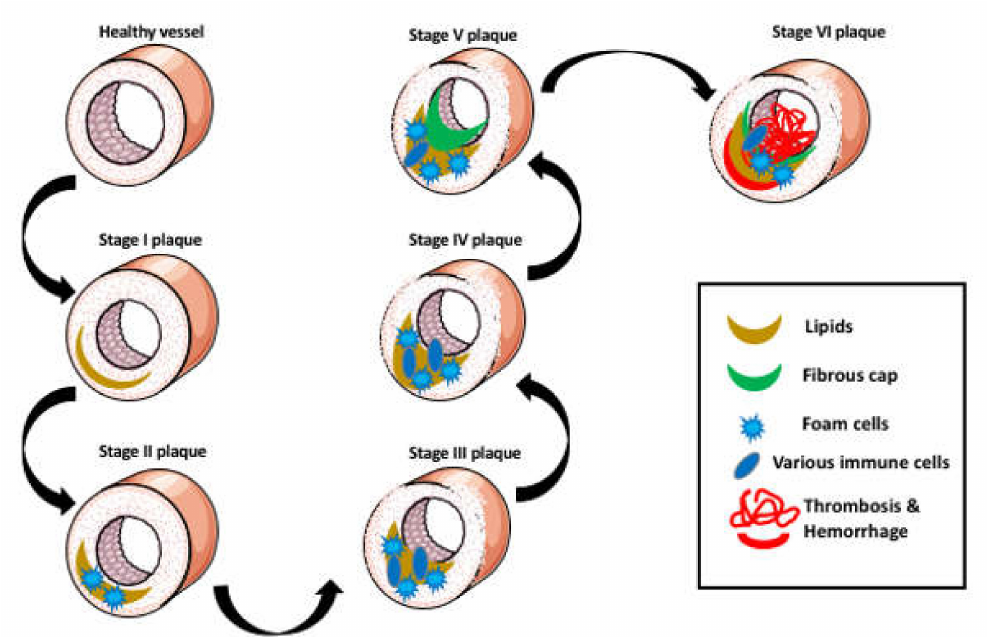
Figure 1. Stages of atherosclerosis progression. The formation of a small area of lipid deposits in the intimal layer is called the stage I lesions. The stage II lesions contain large lipid deposits and lipid-containing foam cells in the arterial wall just beneath the endothelium called the fatty streaks. Stage I and II are called early lesions (plaques). Stage III plaques consist of a large lipid layer filled with the foam cells and other immune cells, which lead to the disorganization and deformation of the artery wall. Stage IV lesions (the atheroma) consist of a large lipid layer. The lipid core causes severe disorganization of the intima. Stage V lesions contain fibrotic tissue on top of the lipid layer. Stage V lesions cause the narrowing of the arterial lumen. Stage VI lesions are vulnerable to plaque rupture, which is followed by thrombosis and